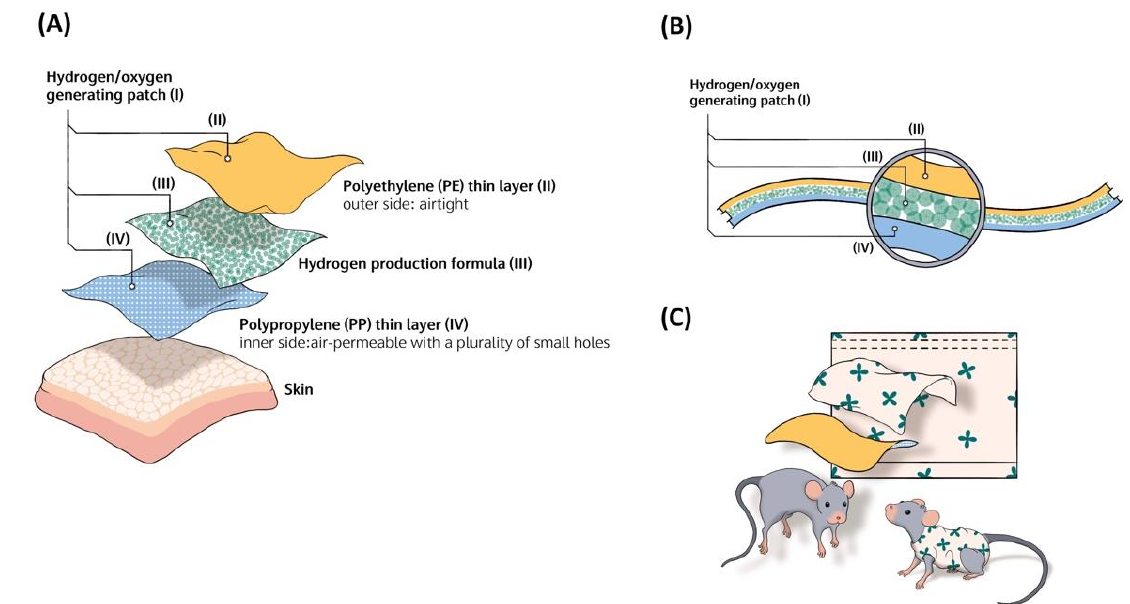
Figure 1. Design of the hydrogen/oxygen-generating patch (HOGP) for the experimental animal model. ( A ) Schematic illustration of the HOGP. ( B ) Detailed images of the HOGP. ( C ) Schematic illustration of the HOGP applied to animals. Stretch fabric was sewn onto the HOGP to secure the patches onto the animals’ skin. Simple Velcro jackets were designed to further secure the patches onto the animals’ dorsum during the experiment.